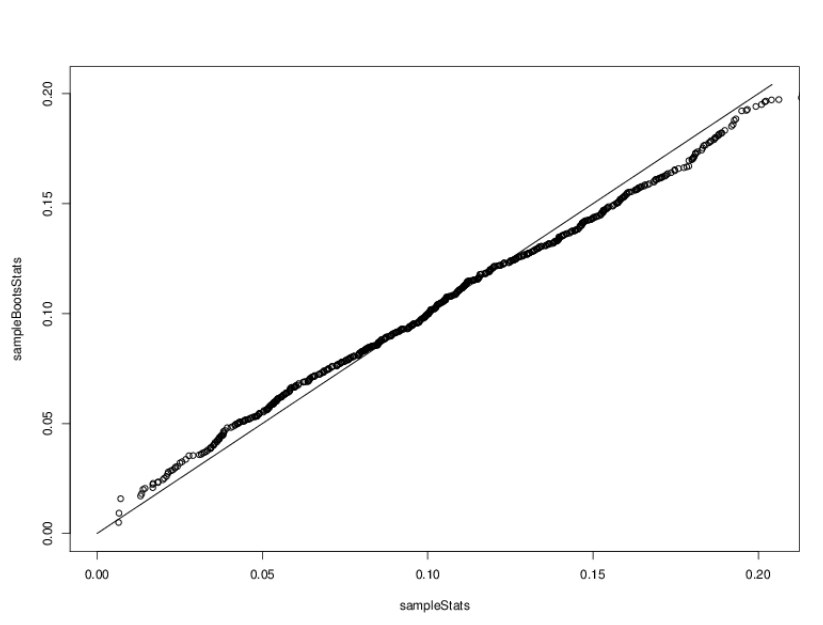
Figure 6: QQ-plot of a sample of the test statistic T 2, c and a sample of the bootstrap test statistic ( T 2, c ) ** using the parametric independent bootstrap for the gaussian copula, with n = 500 and under H c 0 (conditional Kendall’s tau is constant and equal to 0.5 ).